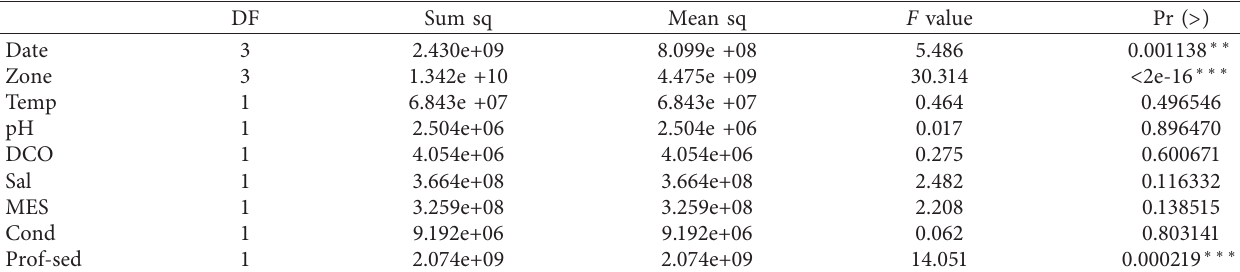
Table 5: ANOVA result between parameters and mercury in the sediment of Lake Nokou´e.